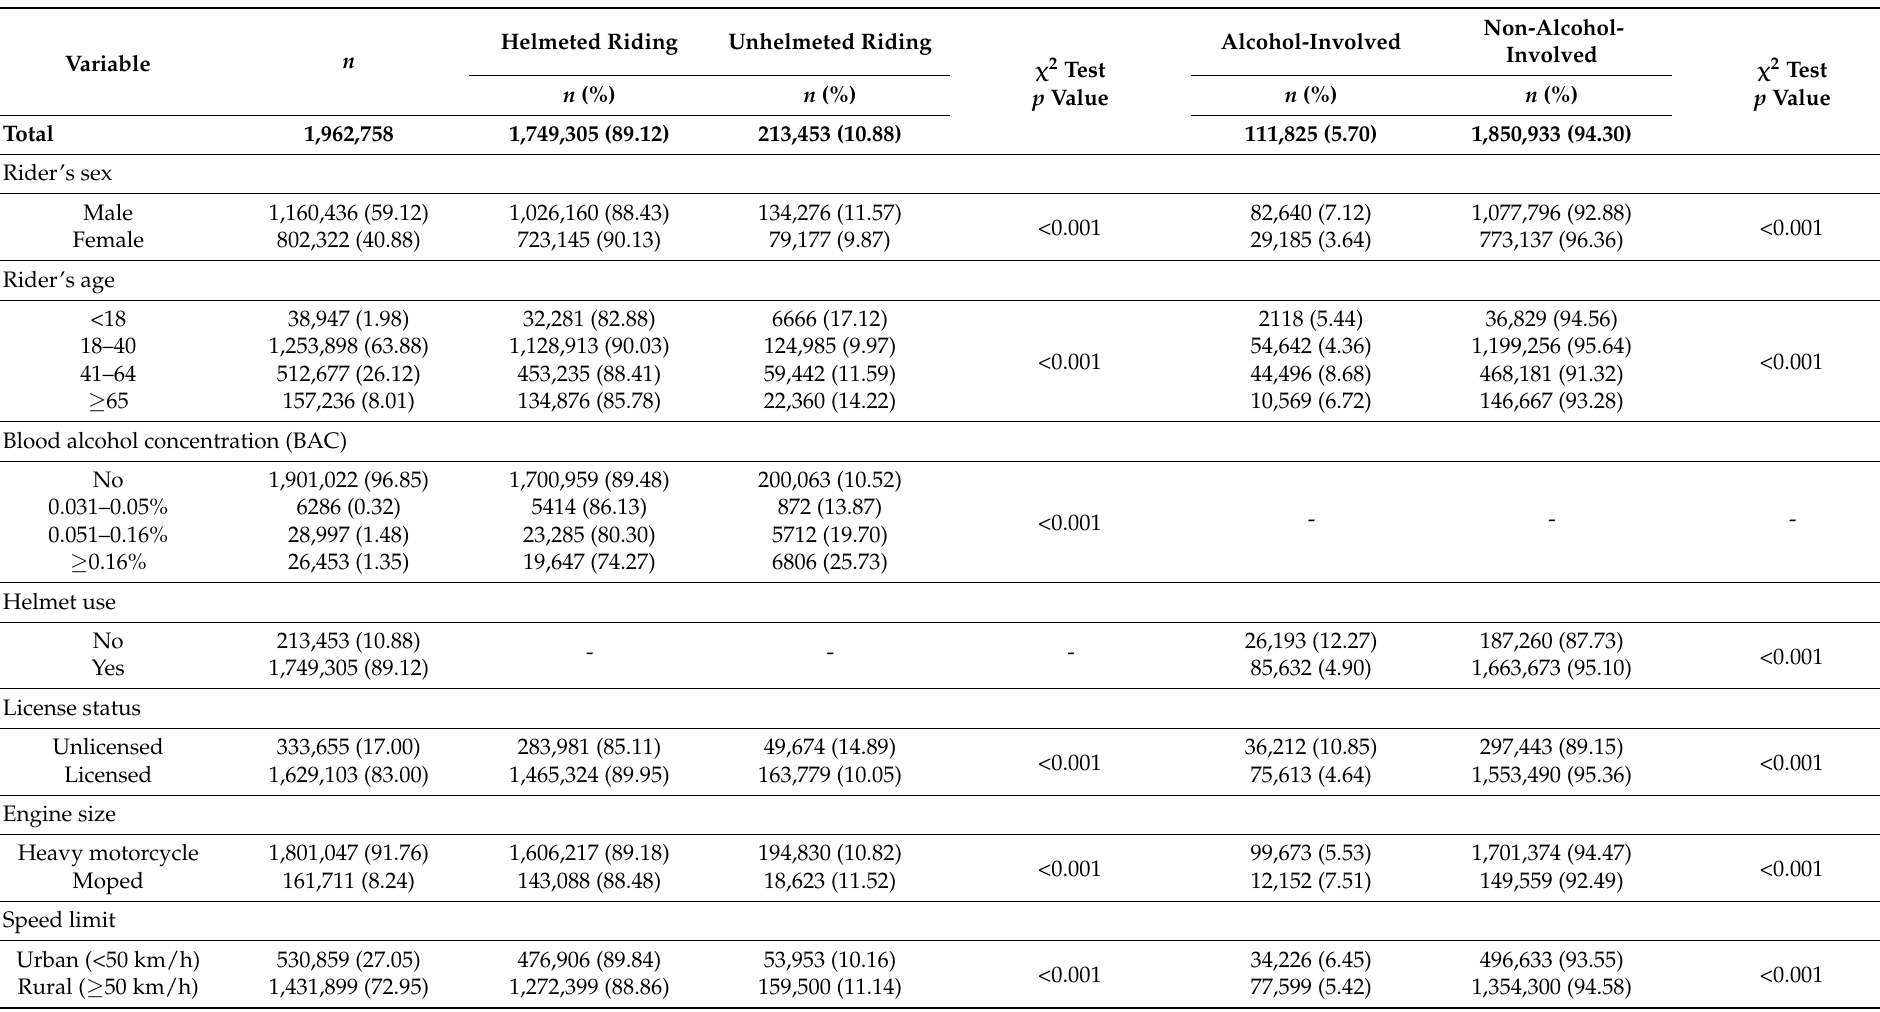
Table 1. Distribution of unhelmeted riding and drunk